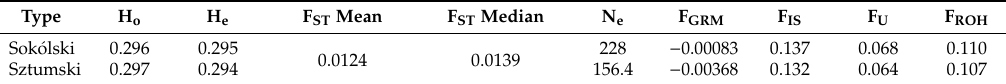
Table 1. Genetic diversity parameters for the studied horse